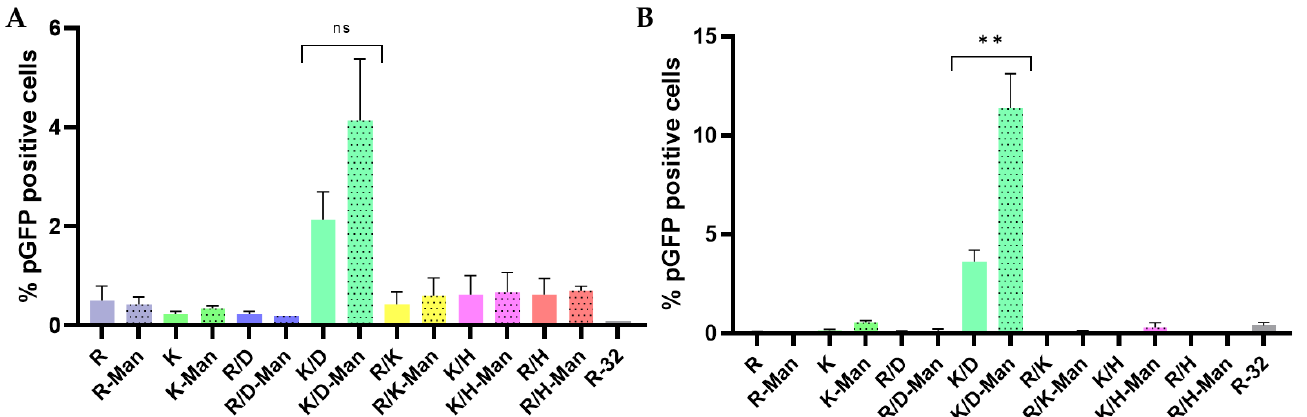
Figure 3. Assessment of PGFP-gene expression by flow cytometry in Langerhans-like cells. MUTZ-3 cells ( A ) and human MoLCs ( B ) after transfection using the library of OM- and MM-PBAEs. Cells were transfected by adding 0.3 µg pDNA/well at a 50:1 polymer:DNA weight ratio. Results are presented as mean and standard deviation of triplicates (mean ± SD). Statistical significance was compared between MM-PBAEs and their non-modified counterpart (ns = non-significant, ** p < 0.01).